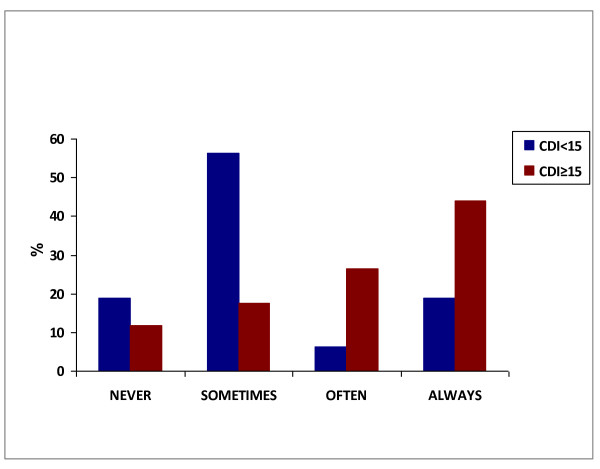
NBI question #27 "I drink more than 3 cups of coffee, cola or tea per day"; Categories were compared by means Fisher's exact test. The "never" category was significantly different from each of the other categories (p < 0.001).